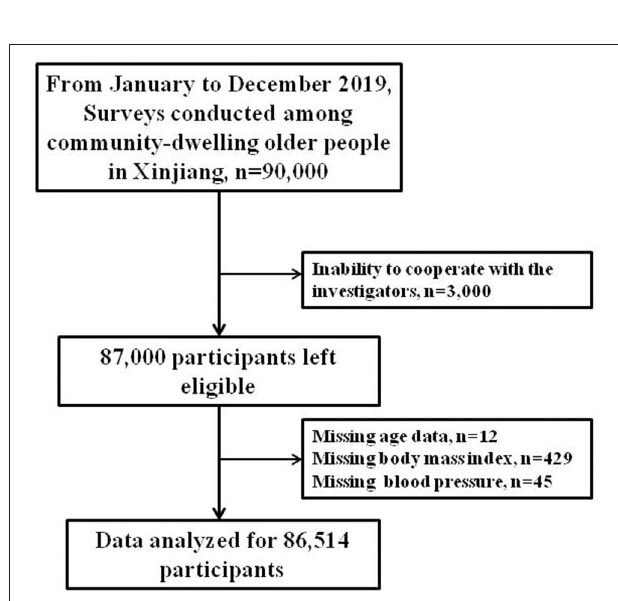
FIGURE 2 | Selection procedure of the study